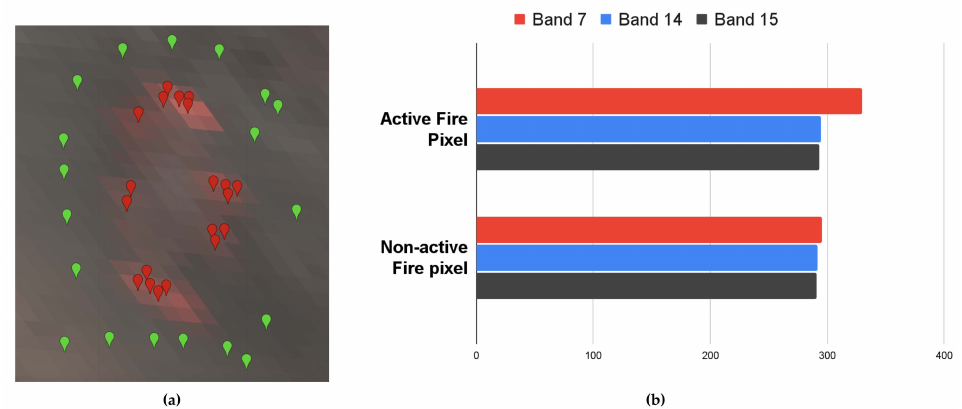
Figure 2. Inspections on the mean values for burning areas and non-burned areas in different bands. ( a ) the GOES-R ABI image captured at 6 p.m. on 8 September 2020, with composition R: Band 7, G: Band 14, B: Band 15. Red pins represent active fire pixels, green pins represent non-active fire pixels. ( b ) The mean values of randomly sampled pixels within burning areas and non-burning areas.